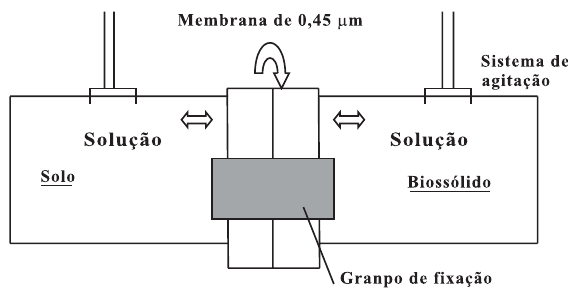
Figura 1. Representação esquemática das câmaras duplas de difusão